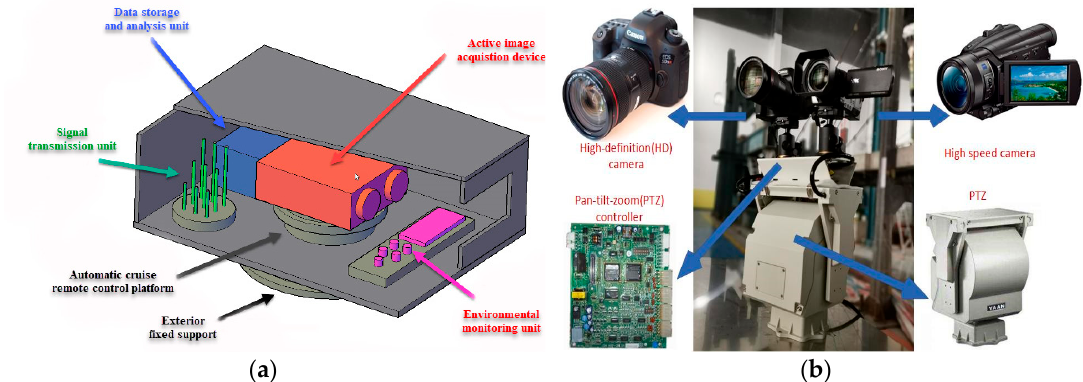
Figure 1. ( a )The architecture of the intelligent noncontact remote sensing (NRS) system; ( b ) the intelligent NRS system for our load tests.